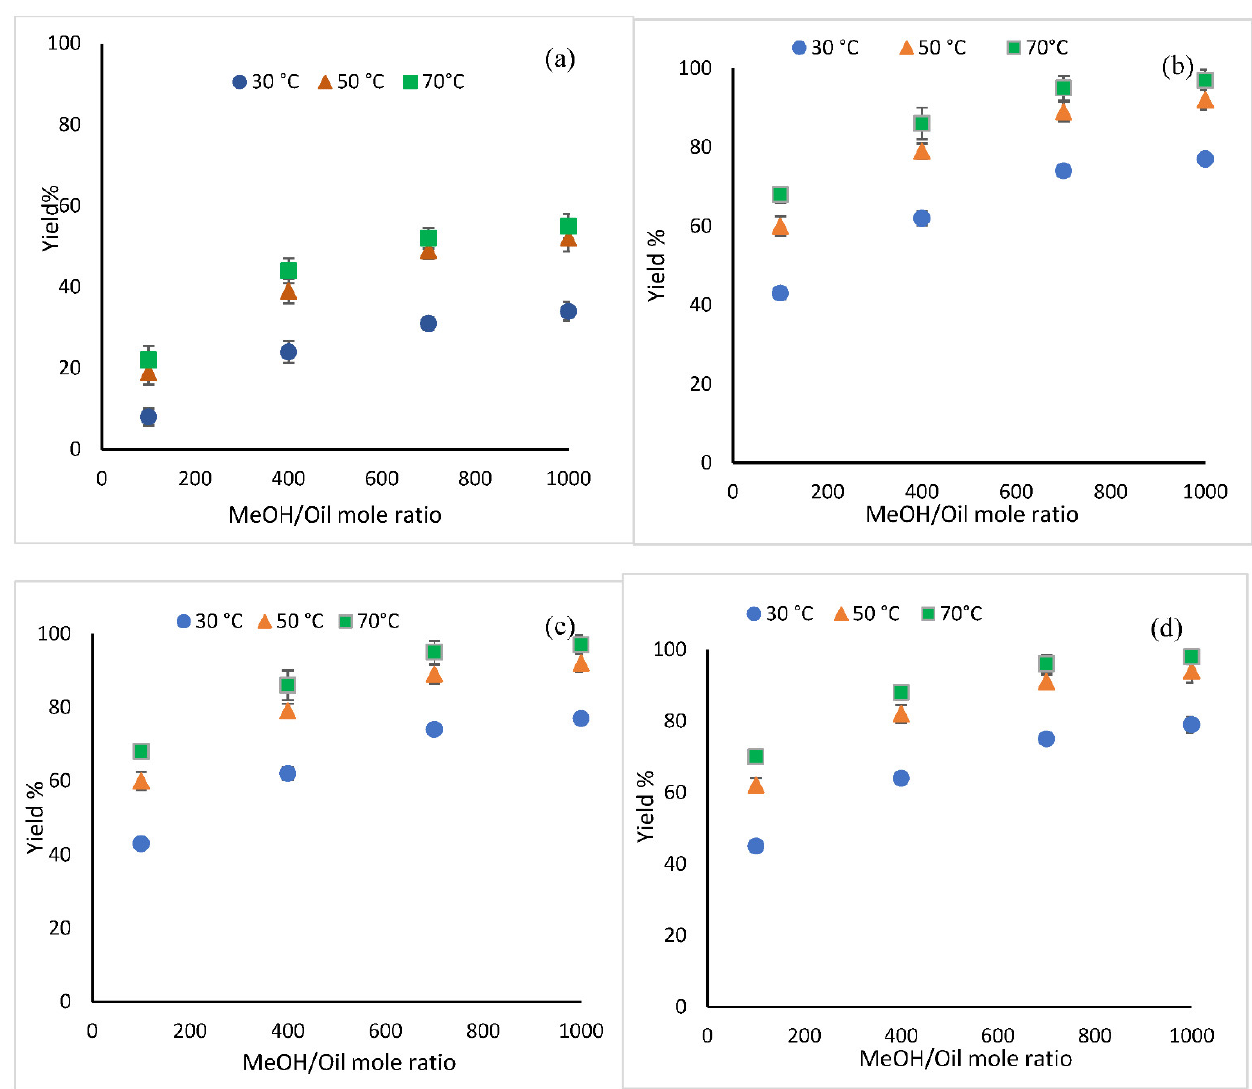
Figure 3. Effect of MeOH/Oil Molar ratio at varying reaction temperature on the FAME yield at reaction times of ( a ) 30 min ( b ) 60 min ( c ) 90 min and ( d ) 120 min.